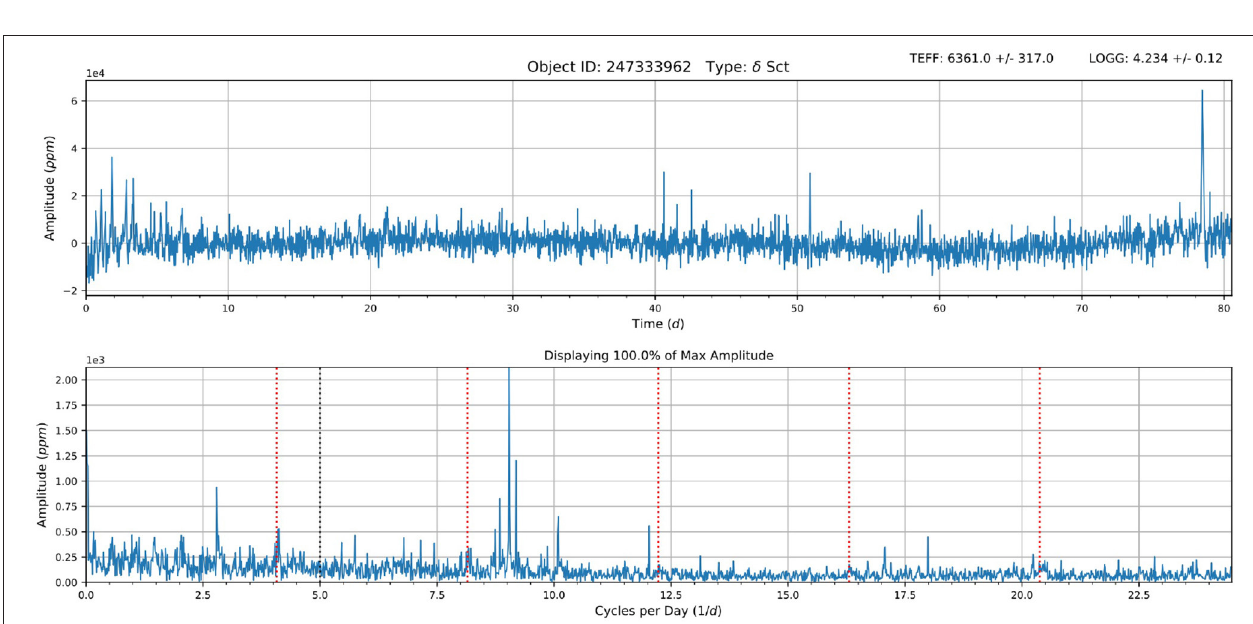
FIGURE 4 | Light curve (Top) and amplitude spectrum (Bottom) for faintest δ Sct candidate, EPIC 247333962, with Kp magnitude 15.9, observed during C13.